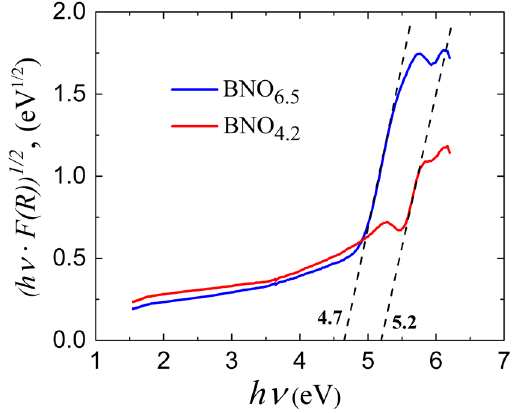
Figure 9. Tauc plots of the BNO 1 and BNO 2 nanopowders containing 6.5 and 4.2 at.% of oxygen.